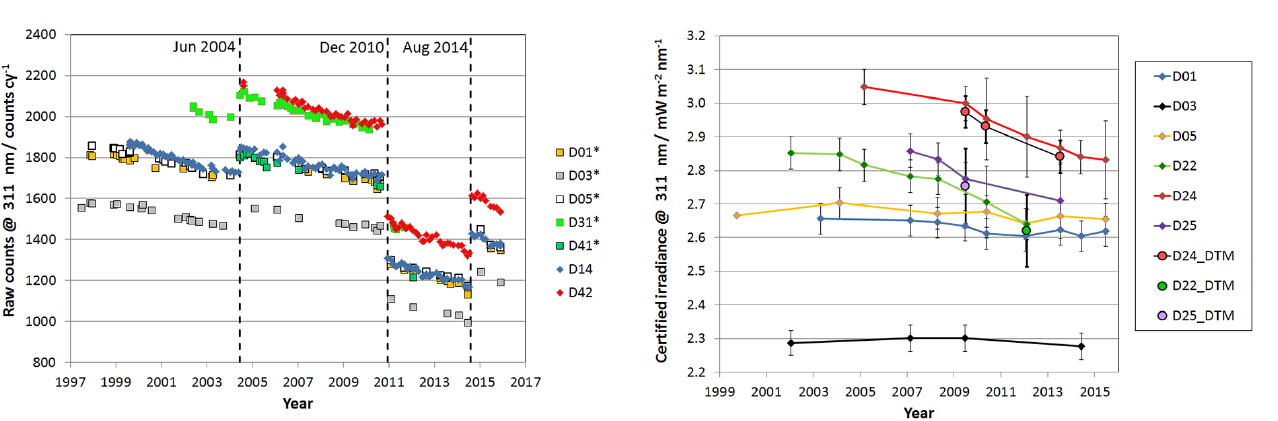
Figure 4. Irradiance at 311nm, as certified by the NSL, of the primary standard lamps used in calibration of Brewer #037 in Sodankylä (D22, D24, and D25) and Brewer #107 in Jokioinen (D01, D03, and D05). The filled circles denote parallel calibrations performed using Bentham DTMc300, extending over wavelengths 250–2100 or 250–2500nm, traceable to another irradiance